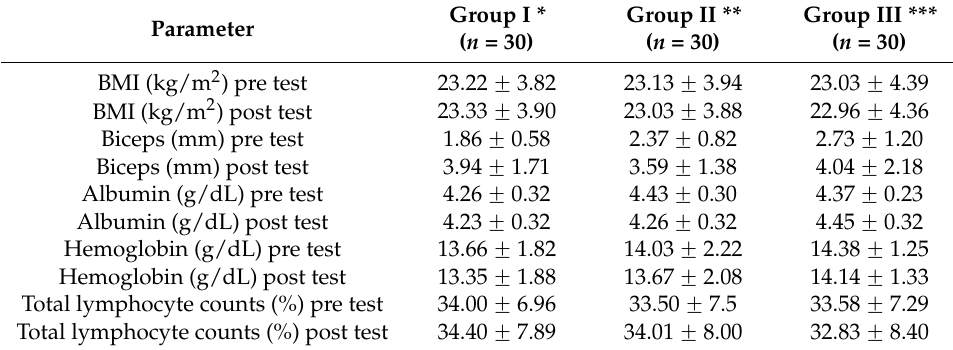
Table 2. Results of anthropometry and blood test of respondents before (pre-test) and after intervention ethnic ready-to-eat foods (post-test) of three groups.